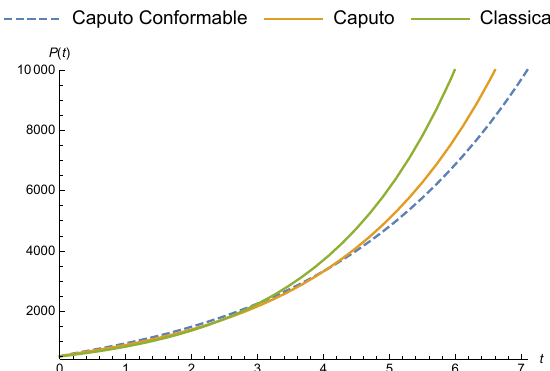
Figure 7. Comparative analysis of the Malthusian growth model with different types of derivatives while α = 0.8, β = 1.